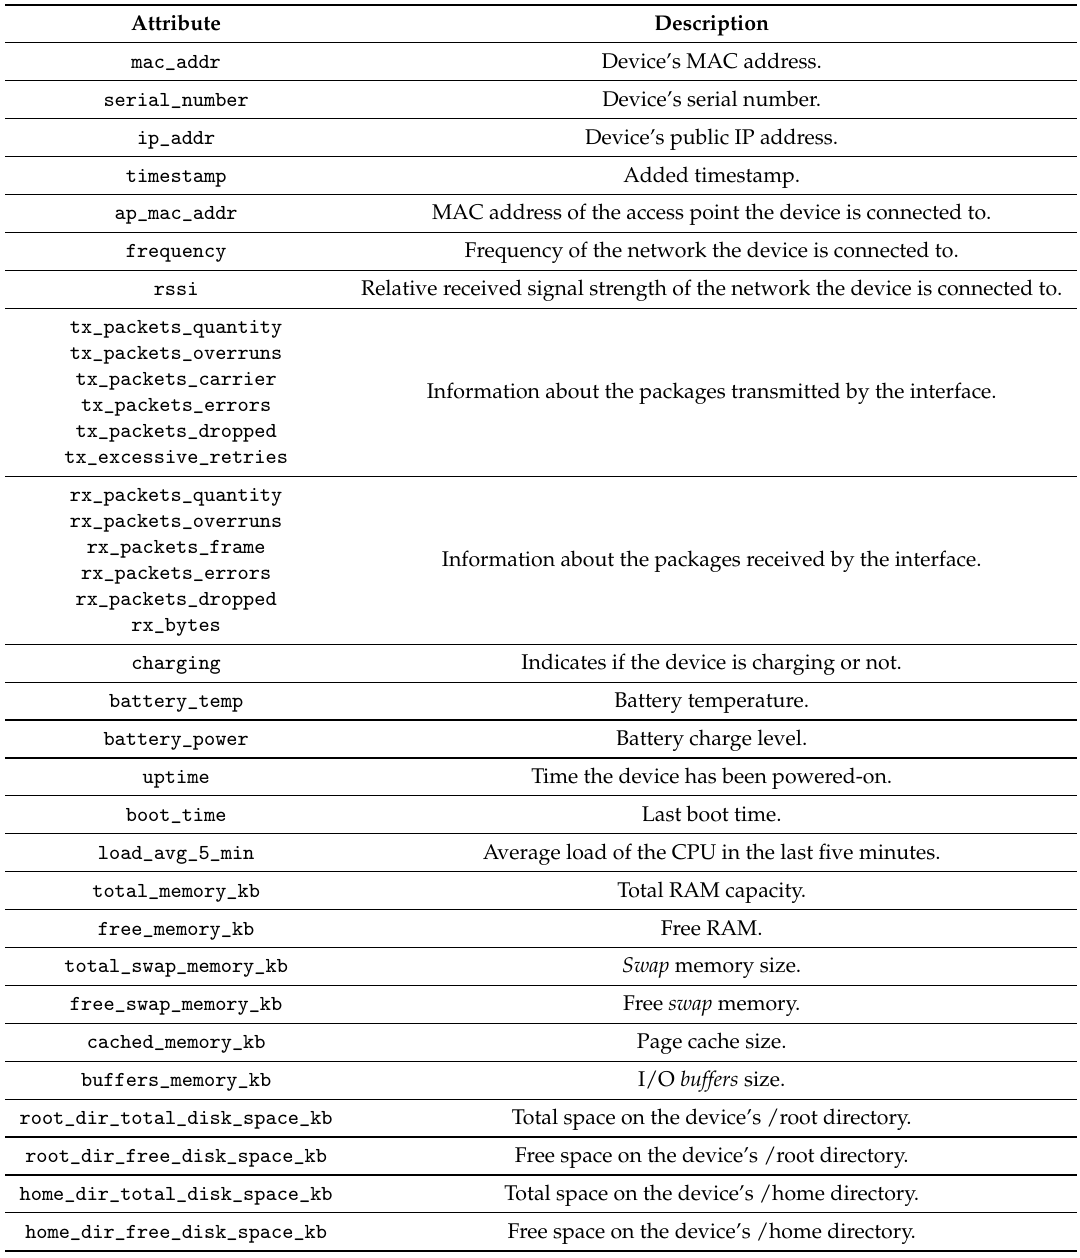
Table 1. Logged data from